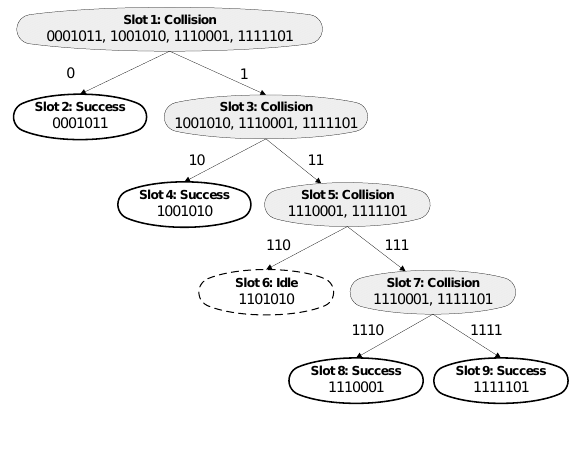
Figure 1. Example of the QT